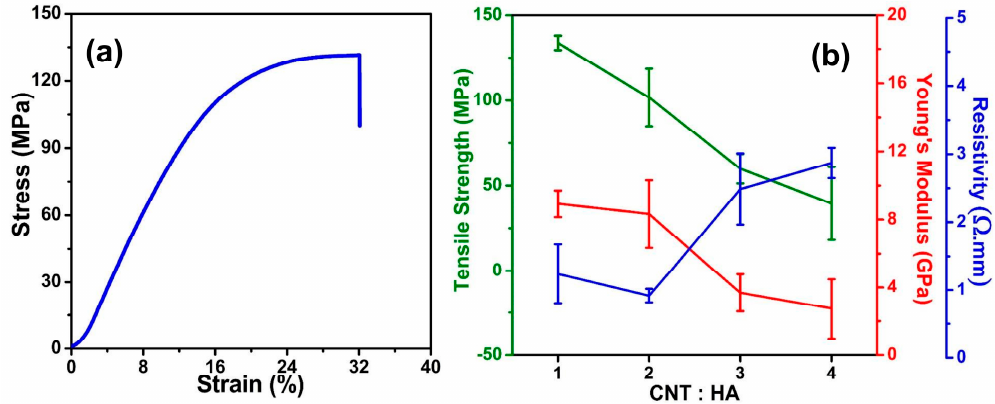
Figure 3. The mechanical and conductivity properties of the HA/MWCNT hybrid microfibers with different ratios of HA to CNTs. ( a ) The stress-strain curve of a HA/MWCNT hybrid microfiber; ( b ) The tensile strengths, Young’s moduli and conductivities of HA/MWCNT hybrid microfibers prepared from different HA:MWCNT ratios.